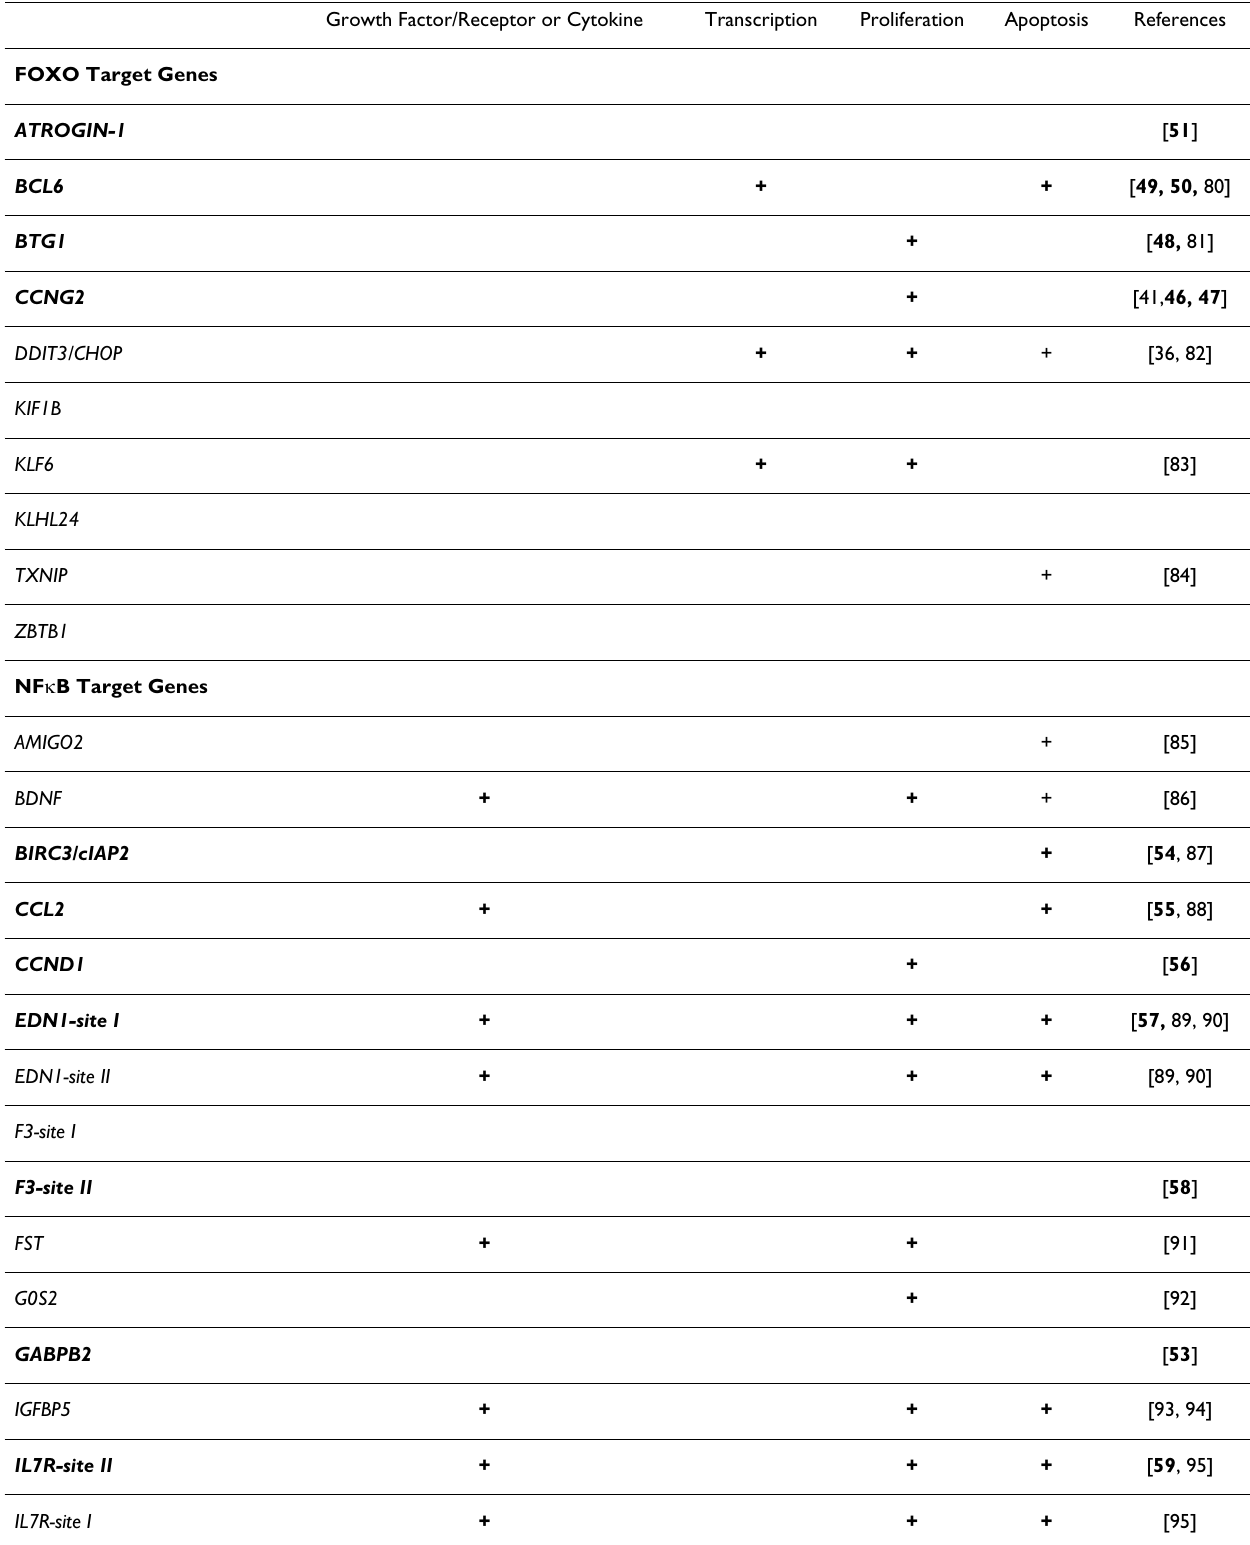
Table 7: FOXO and NF  B regulated genes. Growth Factor/Receptor or Cytokine Transcription Proliferation